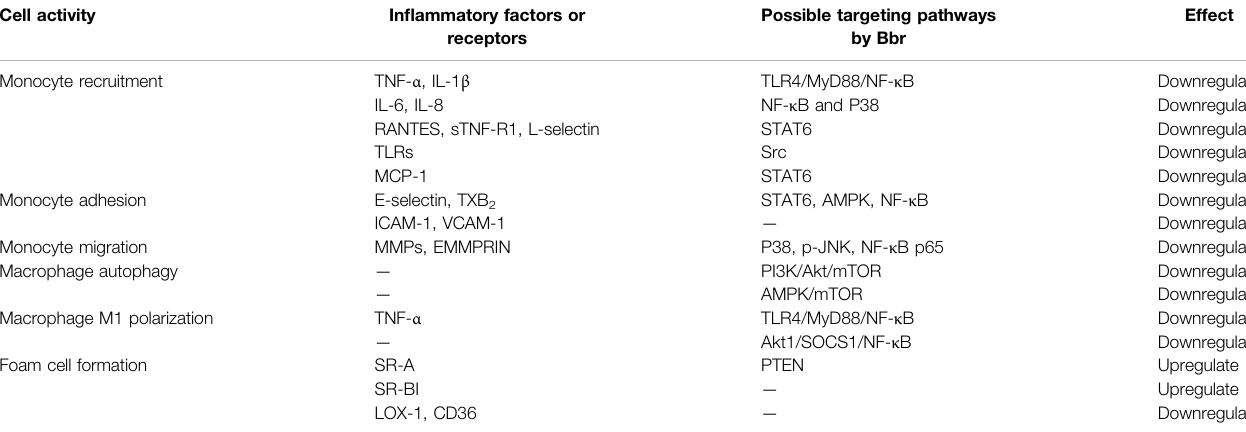
TABLE 2 | In fl ammatory factors and macrophage activity regulated by